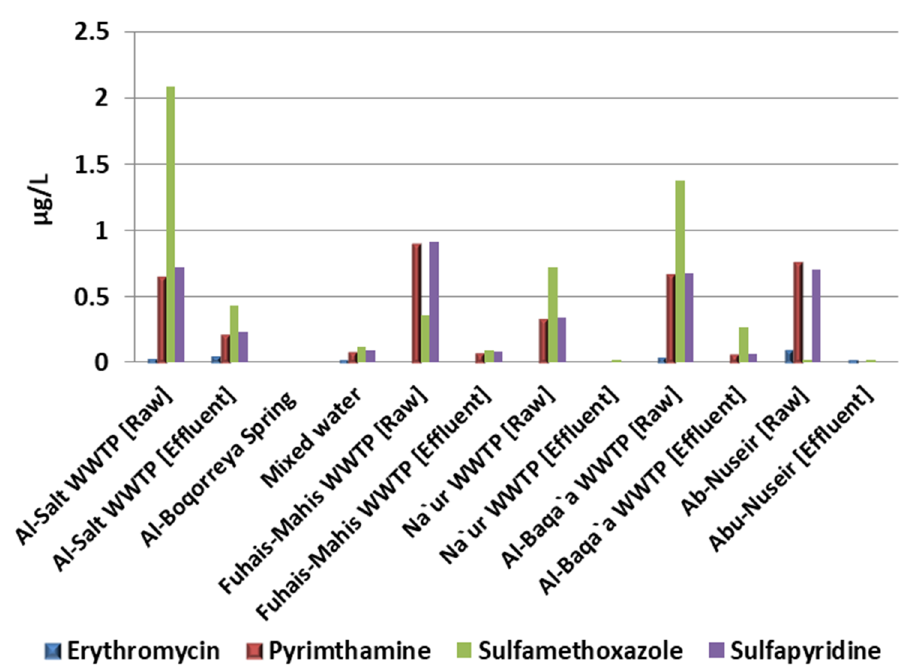
Figure 4. Concentration of sulfapyridine, sulfamethoxazole, pyrimthamine, sulfapyridine, and erythromycin in the investigated water samples.